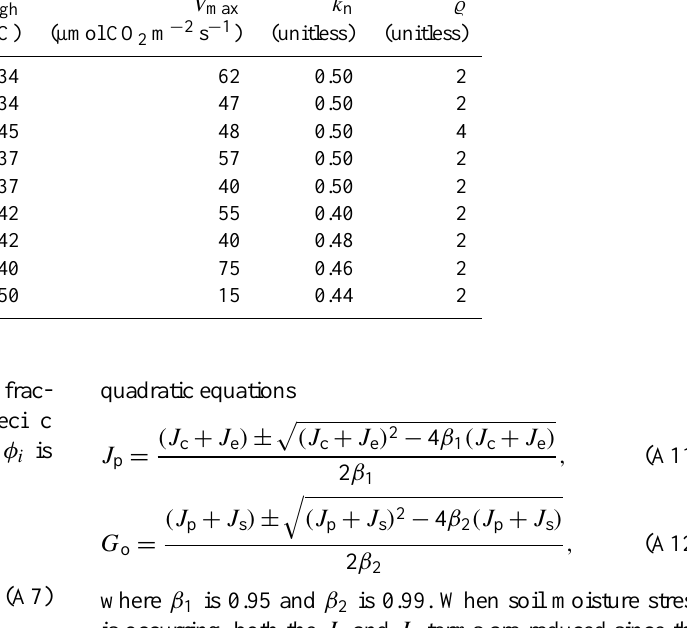
Table A1. Parameters used in the photosynthesis module of CTEM v. 2.0. T low and T high are the lower and upper temperature limits, respectively, used to determine the rate of carboxylation of the enzyme Rubiso (Eq. A4). V max is the maximum rate of carboxylation by Rubisco (Eq. A4). (cid:37) is a parameter describing the PFT sensitivity to soil moisture stress (Eq. A6). k n is the extinction coefficient describing the profile of the nitrogen and time mean PAR along the depth of the canopy (Eq. A16). Plant functional type T